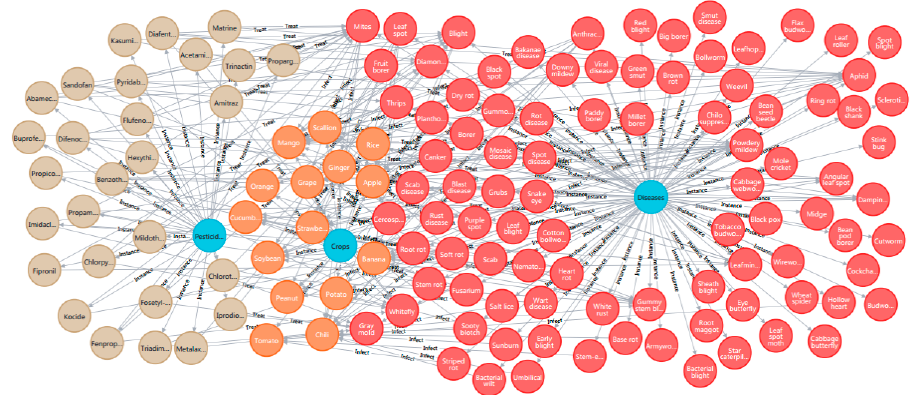
Figure 3. The relations of entities and their instances in the portrait. The light blue circles represent the three entities, the orange circles represent instances of crops, the light gray circles represent instances of pesticides, and the red circles represent instances of diseases and pests.